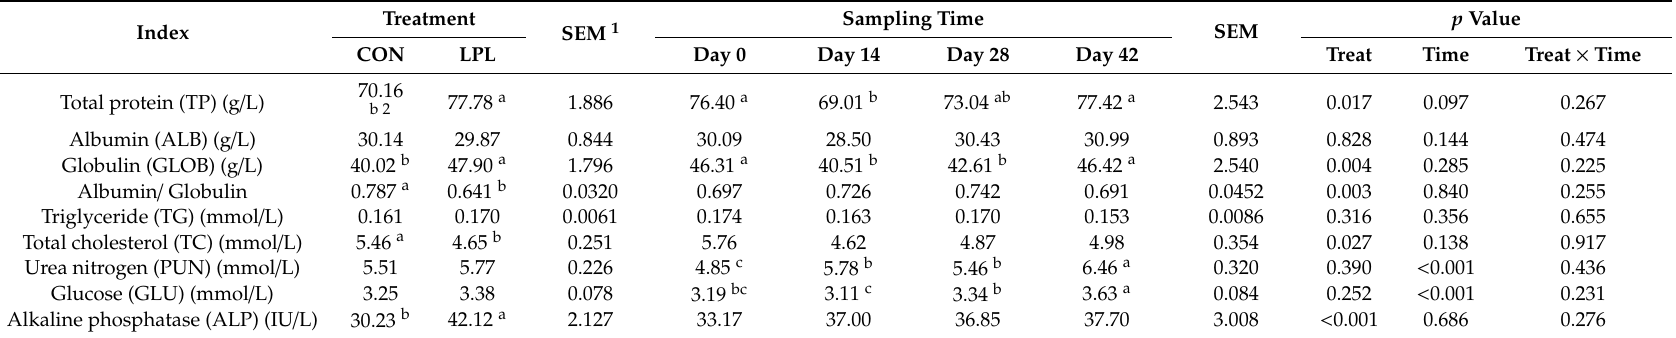
Table 3. Plasma biochemical parameters of dairy cows fed experimental diets supplemented without (CON) or with (LPL)